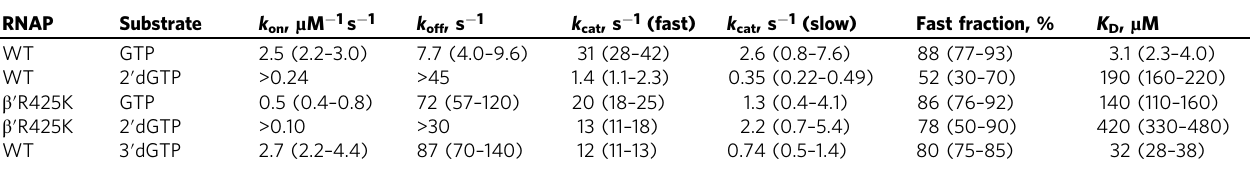
Table 1 Kinetic parameters for the substrate utilization by E. coli RNAPs ( fi t to model 1). RNAP